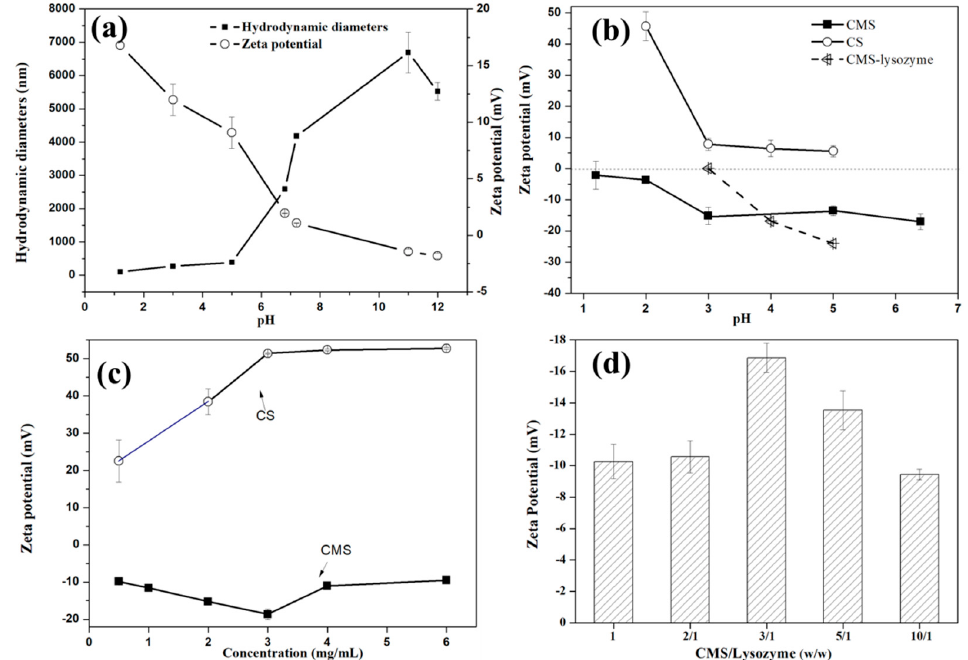
Figure 1. Optimization of preparation procedure according to DLS analysis: ( a ) zeta potential and size as a function of pH of lysozyme, ( b ) zeta potential as a function of pH of CMS, CS and CMS- lysozyme, ( c ) zeta potential as a function of the concentration of CMS and CS, and ( d ) zeta potential as a function of CMS-to-lysozyme mass ratio. Bars represent the corresponding standard deviations ( n = 3).